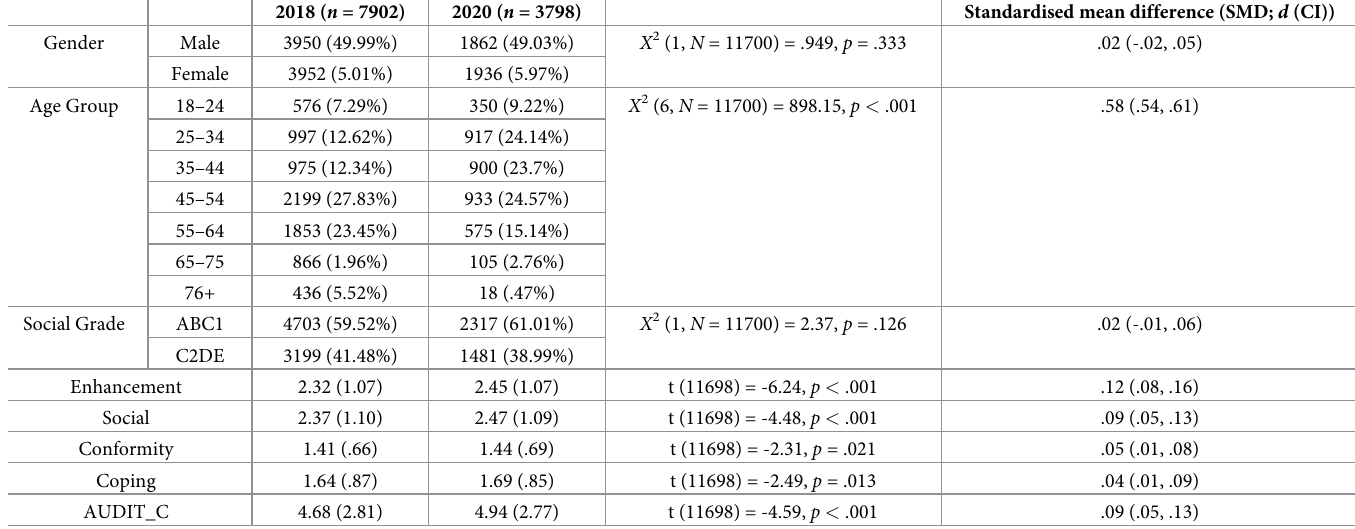
Table 4. Descriptive statistics and group comparisons.